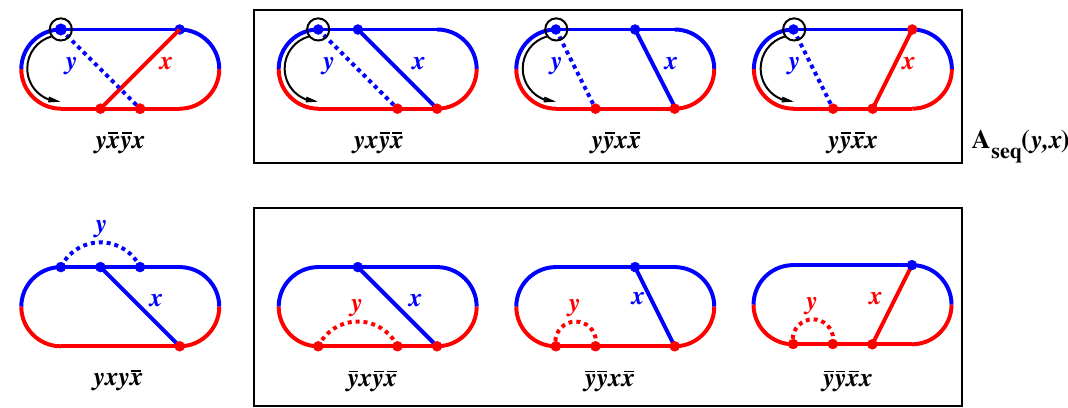
Figure 12 . Diagrams corresponding to the darker-pink rectangles ( β ) in table 1. The g → ggg diagrams (top row) are related by front-end transformation to the virtual g → gg diagrams of the bottom